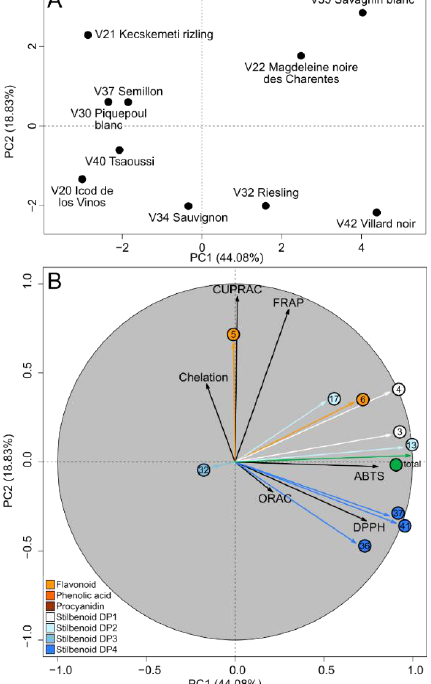
Figure 2. Unsupervised classification using PCA performed on polyphenol-enriched extracts for both antioxidant capacities and polyphenol contents. Score plot ( A ). Loading plot ( B ) with variables colored according to polyphenol class.